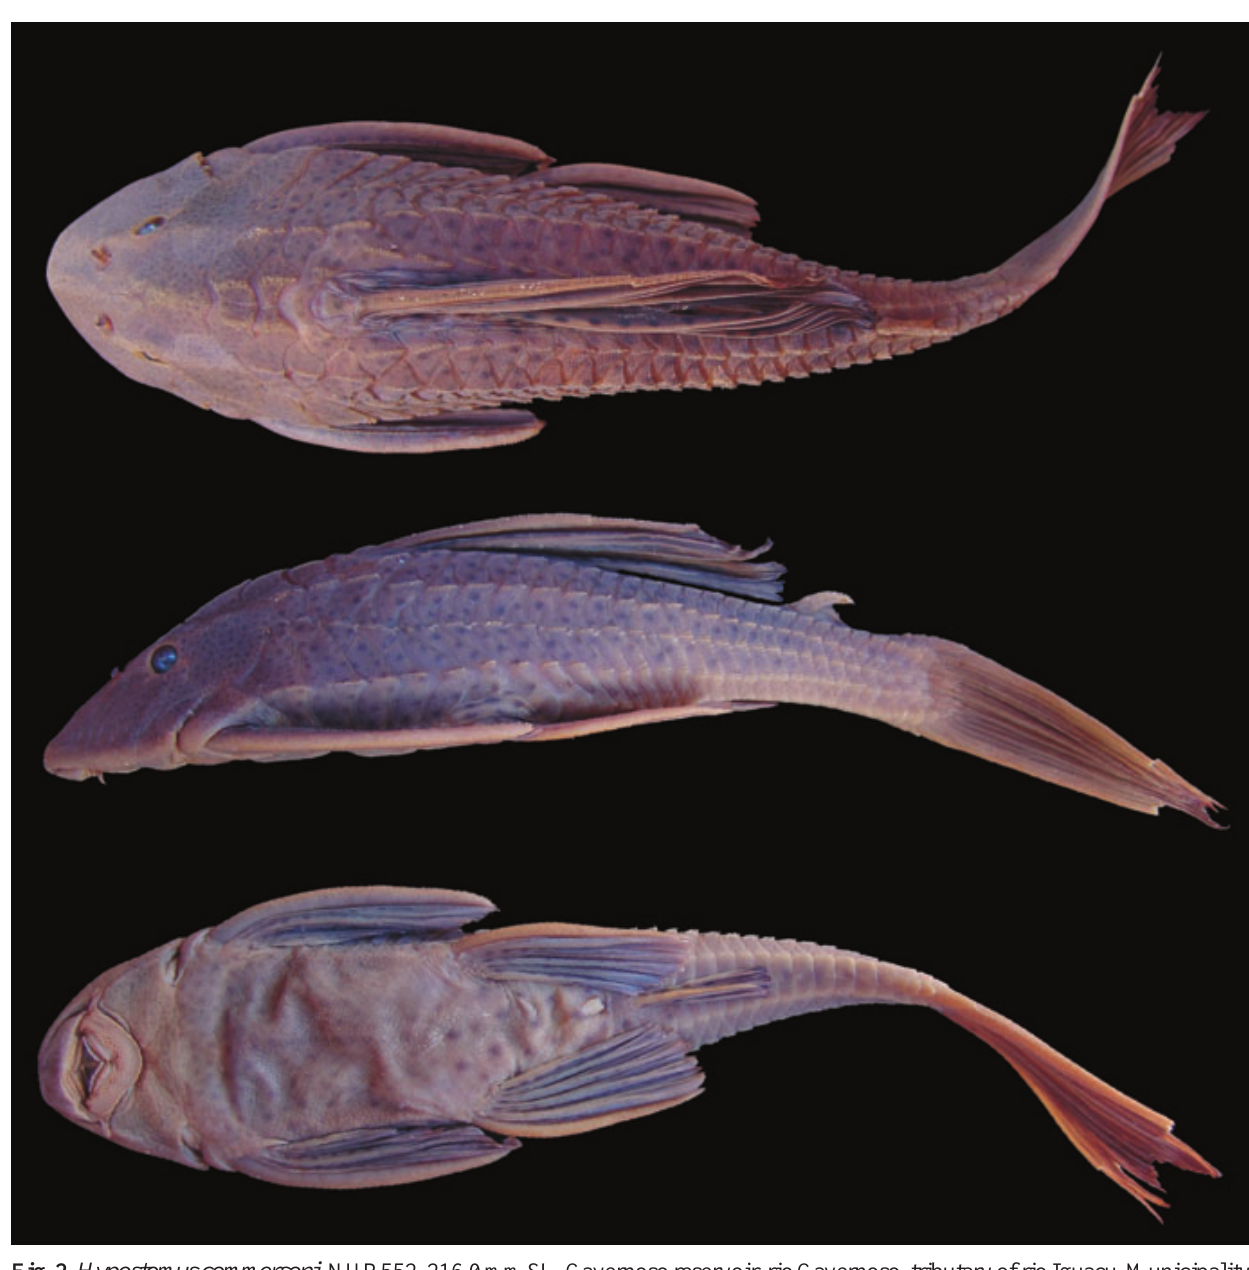
Fig. 2. Hypostomus commersoni , NUP 552, 216.0 mm SL, Cavernoso reservoir, rio Cavernoso, tributary of rio Iguaçu,